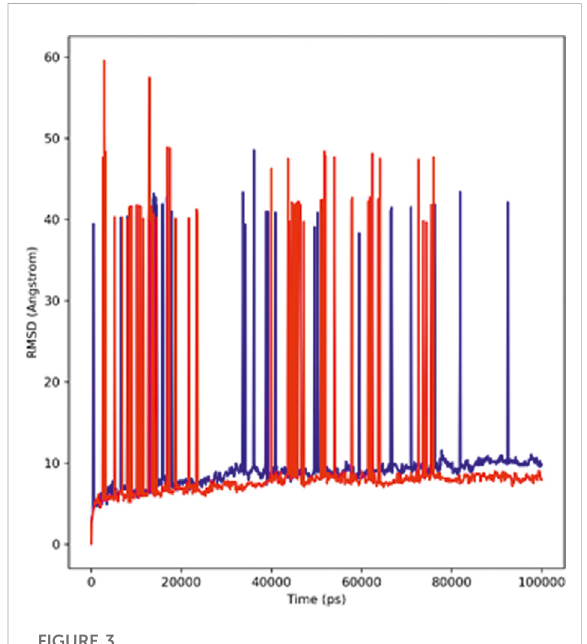
FIGURE 3 RMSD pro fi les of the hTERT – adapalene complex (red) and the hTERT – tamsulosin complex (blue) for 100 ns of MD simulation.